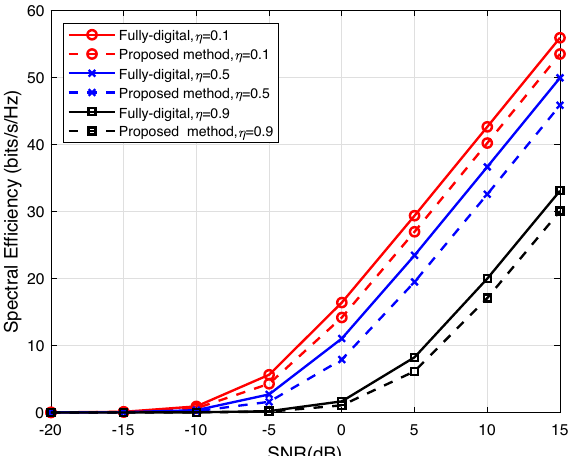
Fig. 5 The SINR of radar versus the for different numbers of radar RF chains with U = 4 , N t = 32 , N RF r = 8 , N rr = 32 , and η =